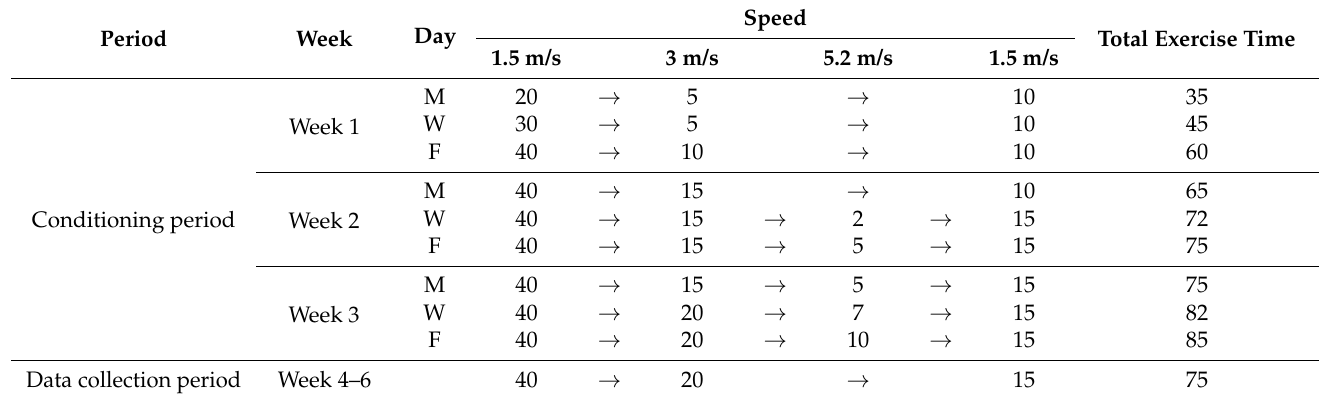
Table A1. Exercise programs in a horse walker machine during conditioning and data collection periods (minutes).